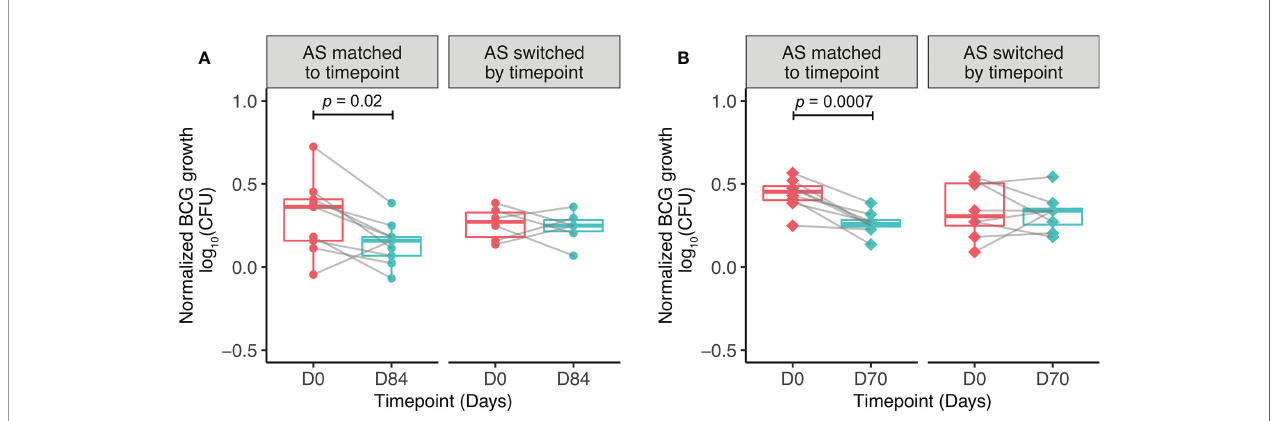
FIGURE 4 | Serum factors contribute to BCG-induced control of mycobacterial growth in vitro . Samples were used from n=9 healthy UK adults enrolled into human Study 1 (A) and n=9 healthy Nepalese military recruits enrolled into human Study 2 (B) , all of whom received ID BCG vaccination. The direct MGIA was performed using PBMC collected at baseline and 84 days (A) or 70 days (B) post-BCG vaccination, co-cultured with BCG and either autologous serum matched to time-point, or autologous serum switched by time-point ie. post-vaccination serum cultured with baseline PBMC and baseline serum cultured with post-vaccination PBMC. Normalized BCG growth = (log 10 CFU of sample - log 10 CFU of growth control). Points represent the mean of duplicate values, boxes indicate the median value with the interquartile range (IQR) and the upper whisker extends to the largest value no further than 1.5 * IQR from the hinge, the lower whisker extends from the hinge to the smallest value at most 1.5 * IQR from the hinge. Outliers are plotted individually. A paired t-test was used to compare between